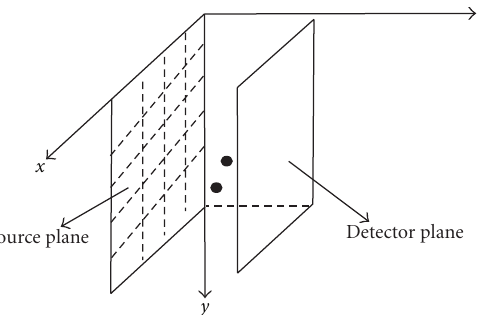
Figure 1: Light intensity distribution on the detector plane is recorded when a point source scans on the source